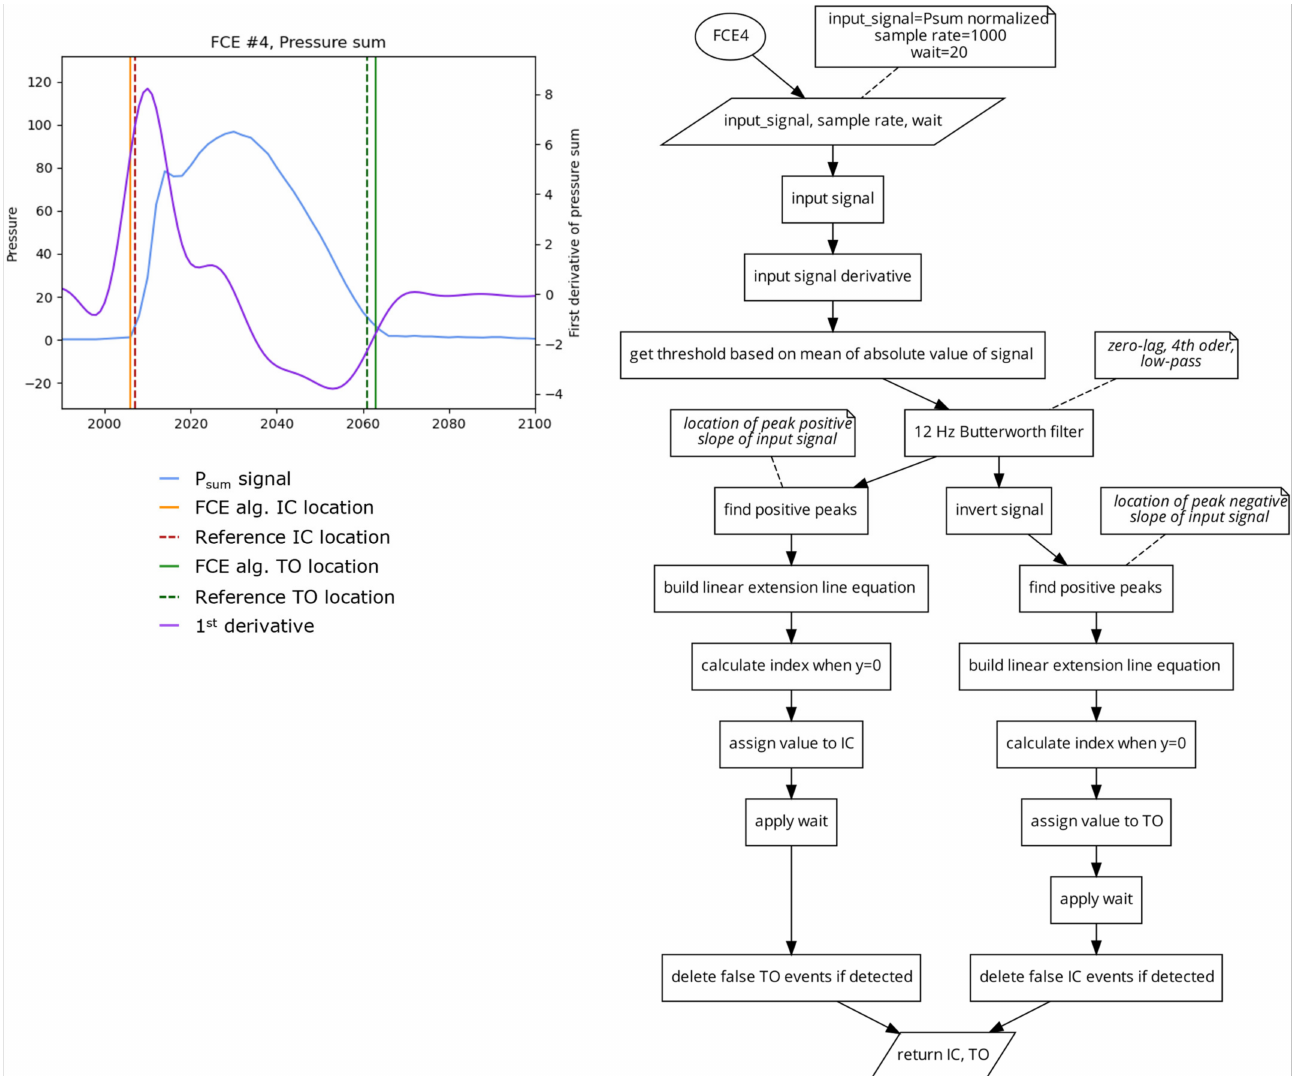
Figure 7. Plot ( left ) displaying a single stride and the location of the reference FCEs (dashed vertical) and the FCEs (solid vertical), as determined by the FCE4 algorithm ( right